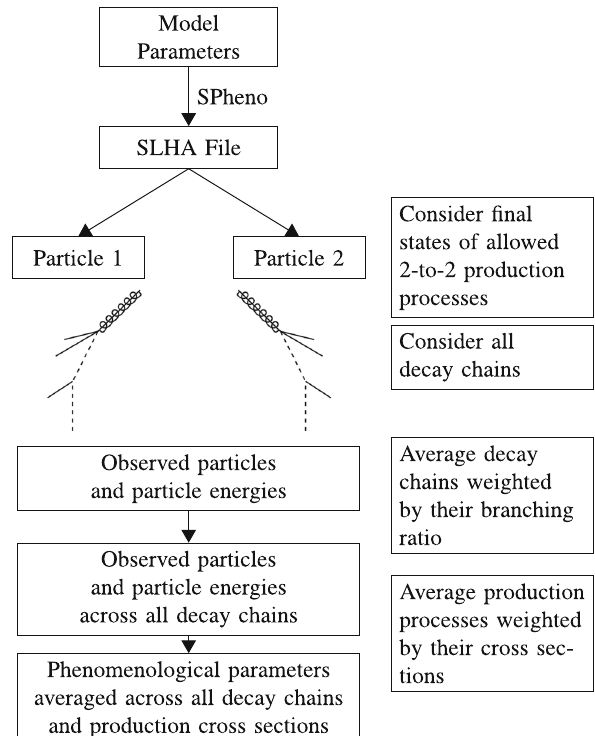
Fig. 12 Flowchart of the reparametrization